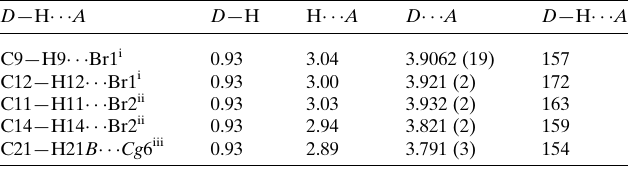
Table 1 Hydrogen-bond geometry (A˚ , (cid:3) ).